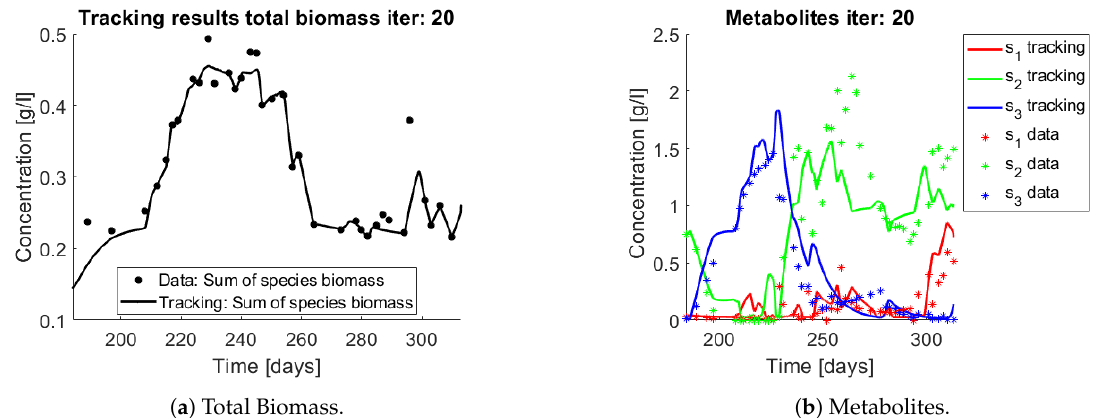
Figure 11. Results on applying the tracking method to a nitrification experiment when regrouping OTU in their functional groups. Data points are represented by asterisks. The continuous line represents the tracking procedure